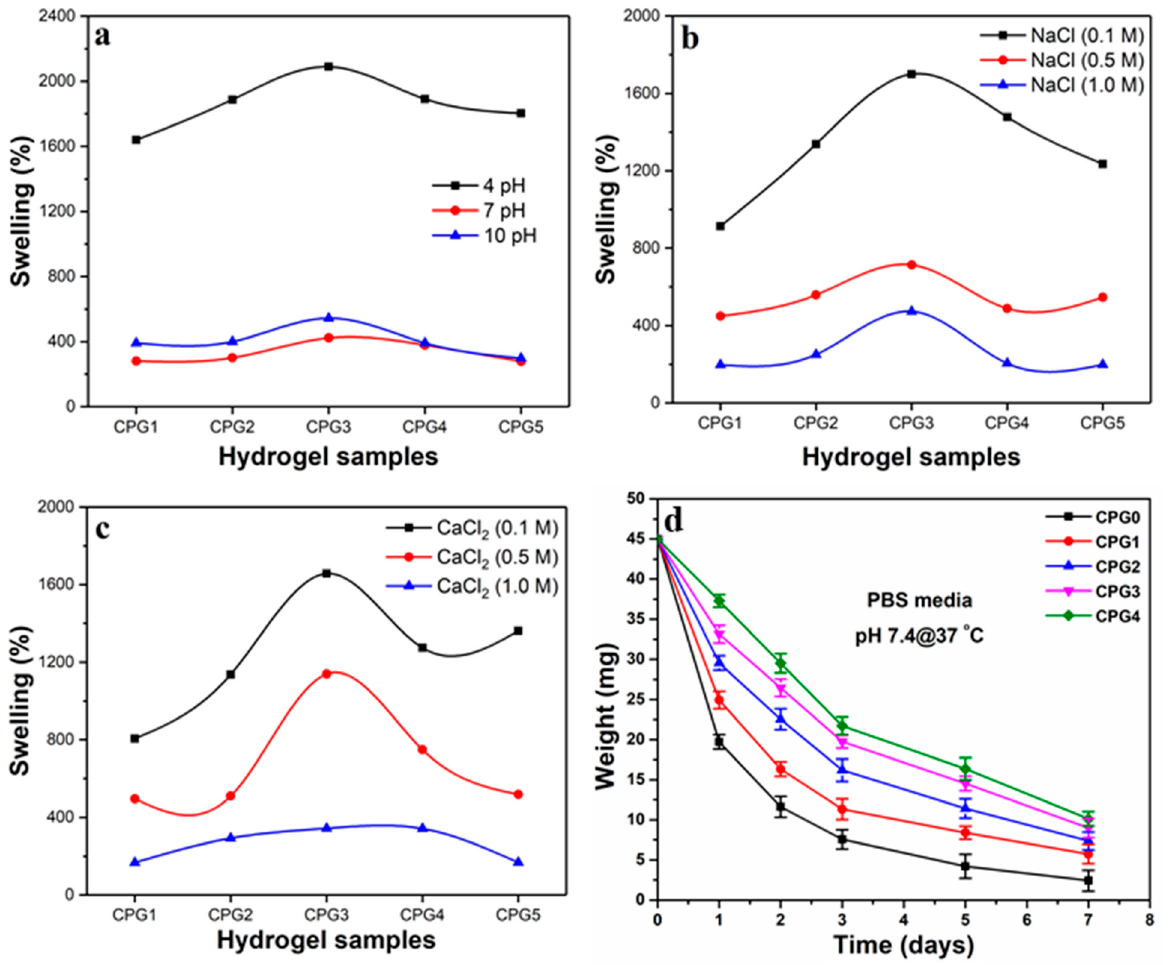
Figure 4. The swelling behavior of hydrogels (CPG0, CPG1, CPG2, CPG3 and CPG4) was analyzed in different media. ( a ) Swelling in aqueous media, ( b ) swelling in NaCl media, ( c ) swelling CaCl 2 media and ( d ) degradation of hydrogels in PBS media.